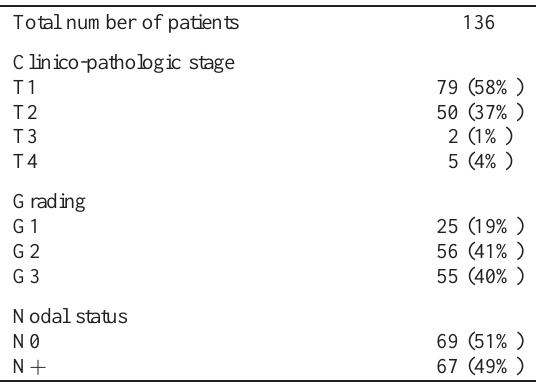
Table 1 Clinico-pathologic characteristics of the study population a Total number of